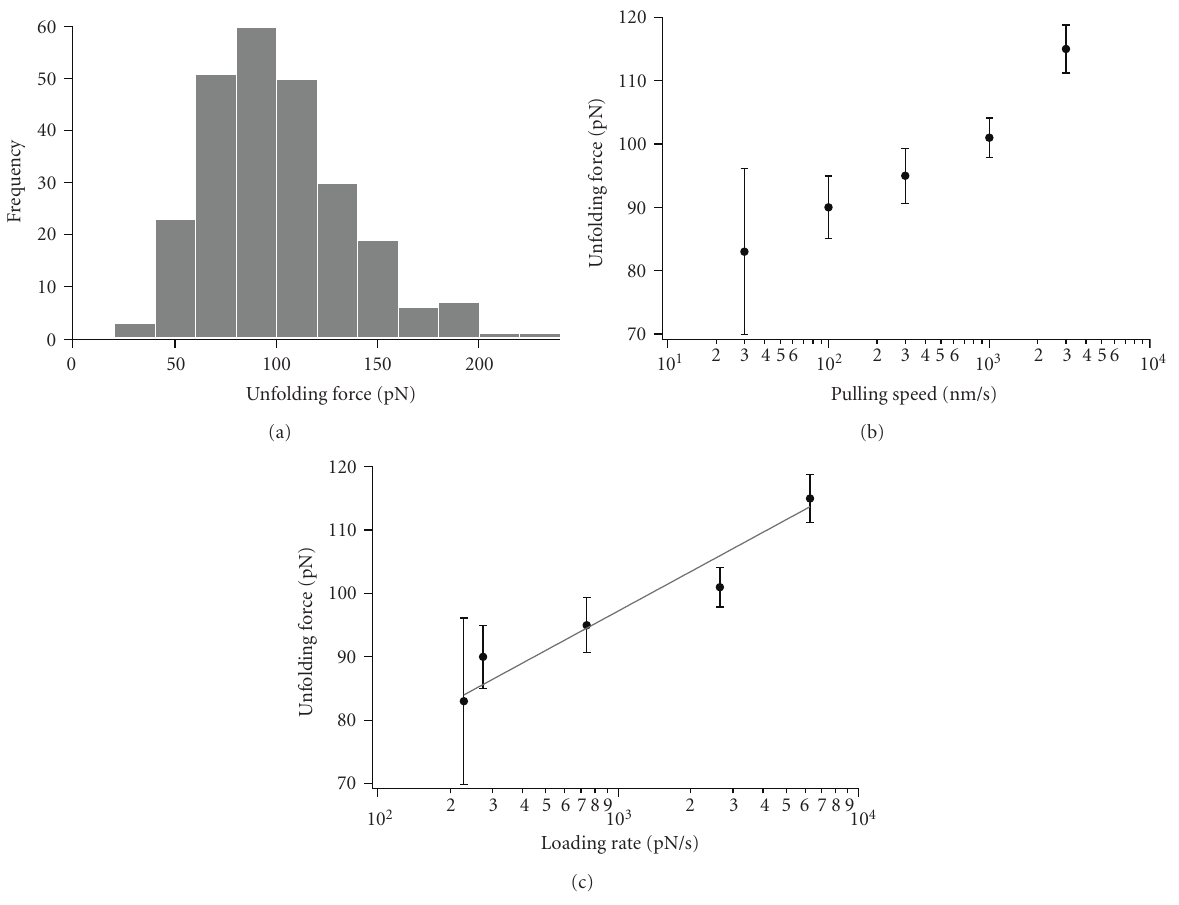
Figure 3: (a) Distribution of unfolding forces of Z1Z2 at 500 nm/s pulling speed. (b) Instantaneous unfolding force versus pulling speed. Error bars represent SEM; the average number of data points for the di ff erent pulling speeds was 25. (c) Unfolding force versus loading rate. The average number of data points for the di ff erent loading rates was 23. Data were fitted with